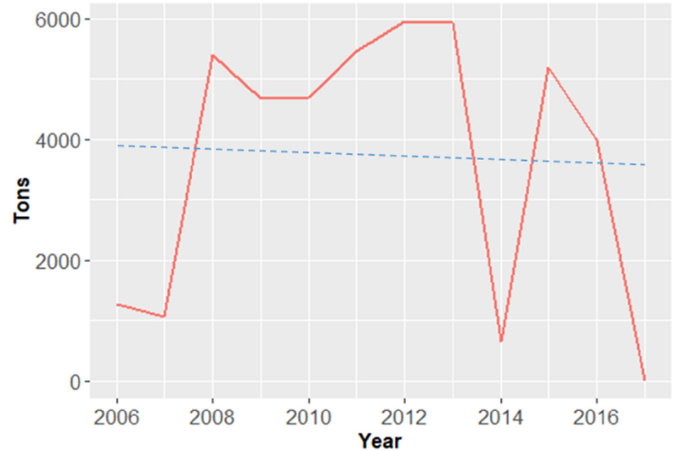
Figure 6. Annual bean production (in tons) of the five most cultivated and traded legume species in Cabo Verde, from 2006 to 2017 [27,33].